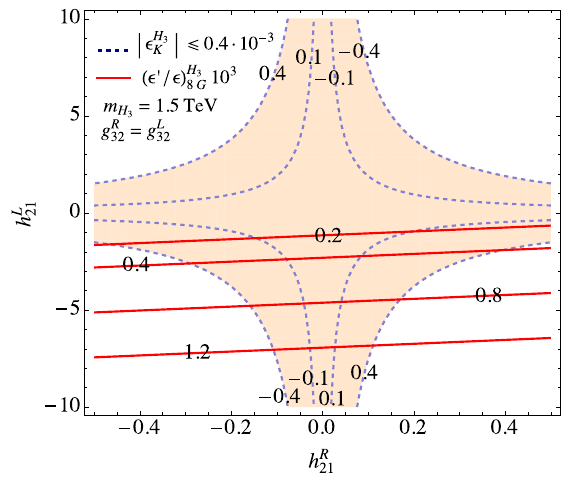
H 3 0 =(cid:15) ) 8 G